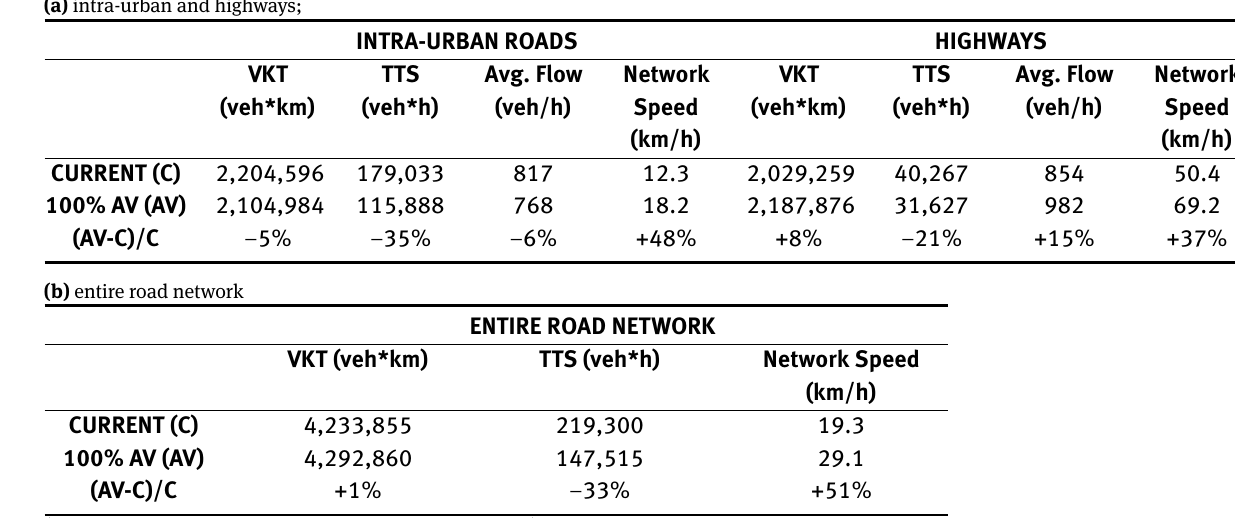
Table 2: Simulation